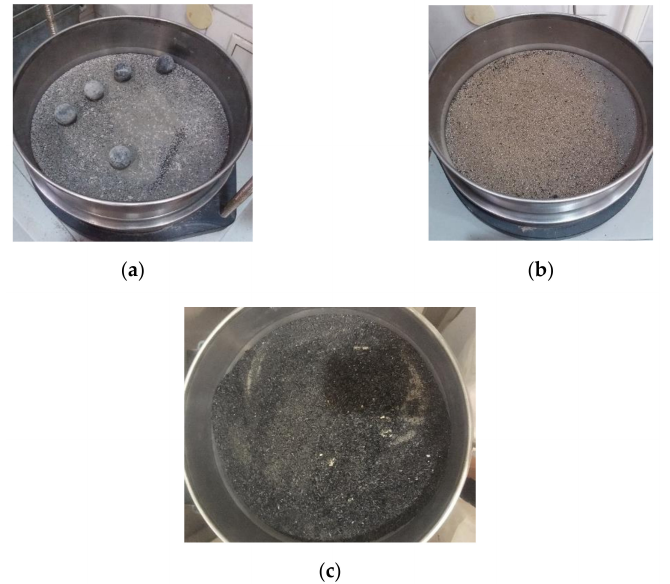
Figure 1. Selective removal of obvious impurities, such as unburnt pieces of wood or coal residues- residues of the sieve 0.25 mm for: ( a ) WBA1 and rubber balls used for sieving; ( b ) WBA2; ( c )